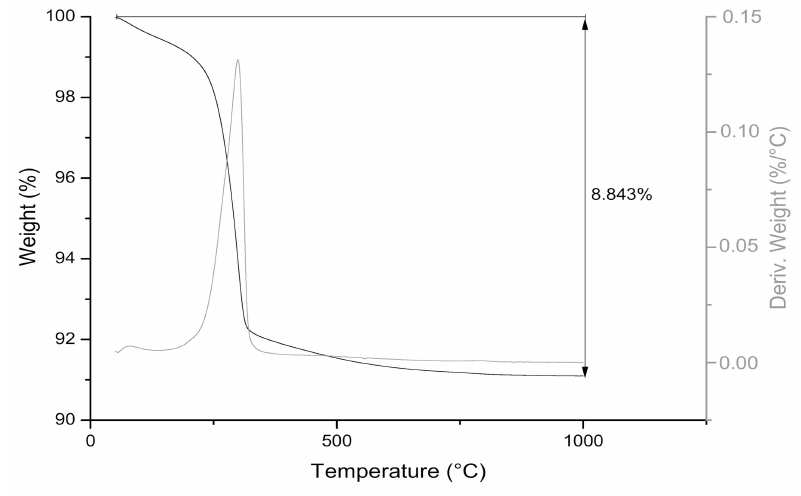
Figure 4. Thermogram of the size fraction − 45 µ m of the amphibolitic itabirite